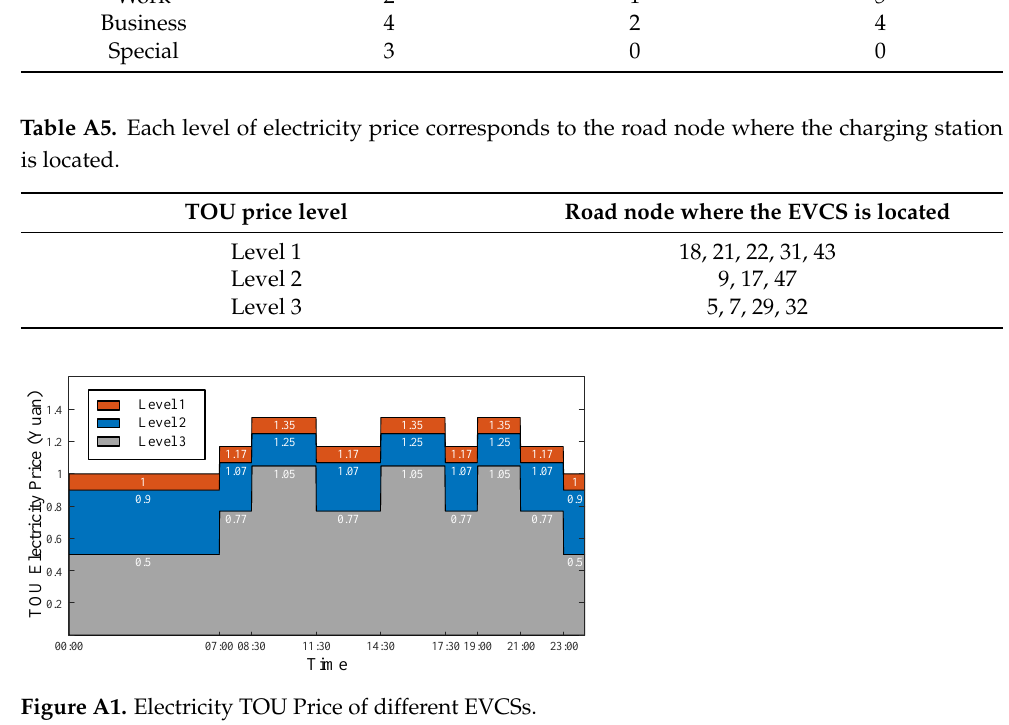
0 Table A2. OD matrix at 17:00~22:00 on weekdays. Departure \Destination 0 Table A3. OD matrix at 22:00~7:00 (+1) on weekdays.